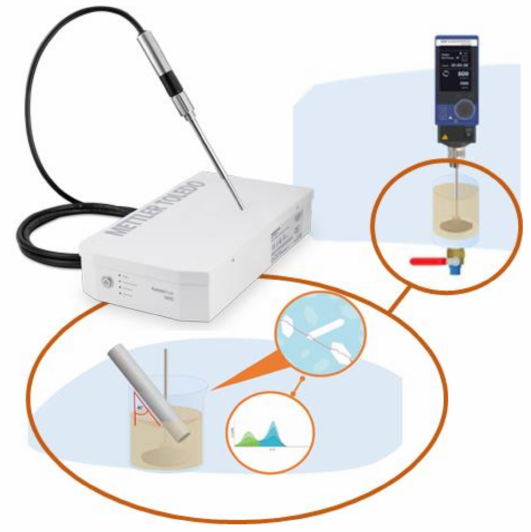
Figure 4. Representation of floc size detection system with FBRM